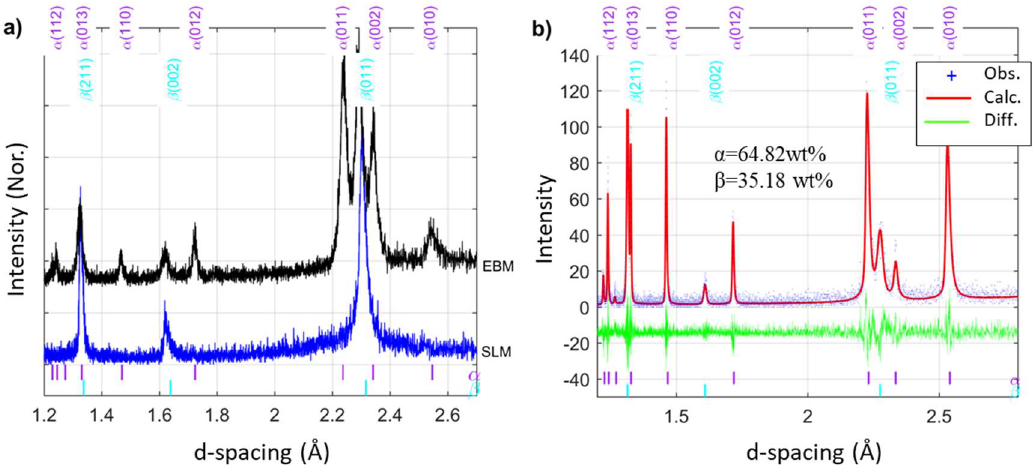
Figure 9. ( a ) Di ff raction pattern of as-built samples. These color-coded tick marks under the di ff ractogram correspond to the expected peak positions of reported α - and β -Ti phases. ( b ) Rietveld refinement result of XRD data from EBM build